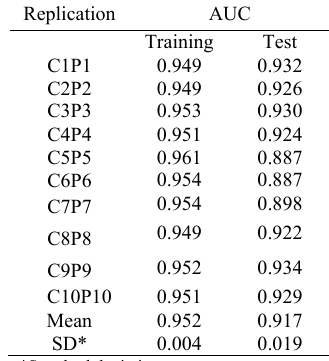
Table 5: Computed AUC values for training and test data